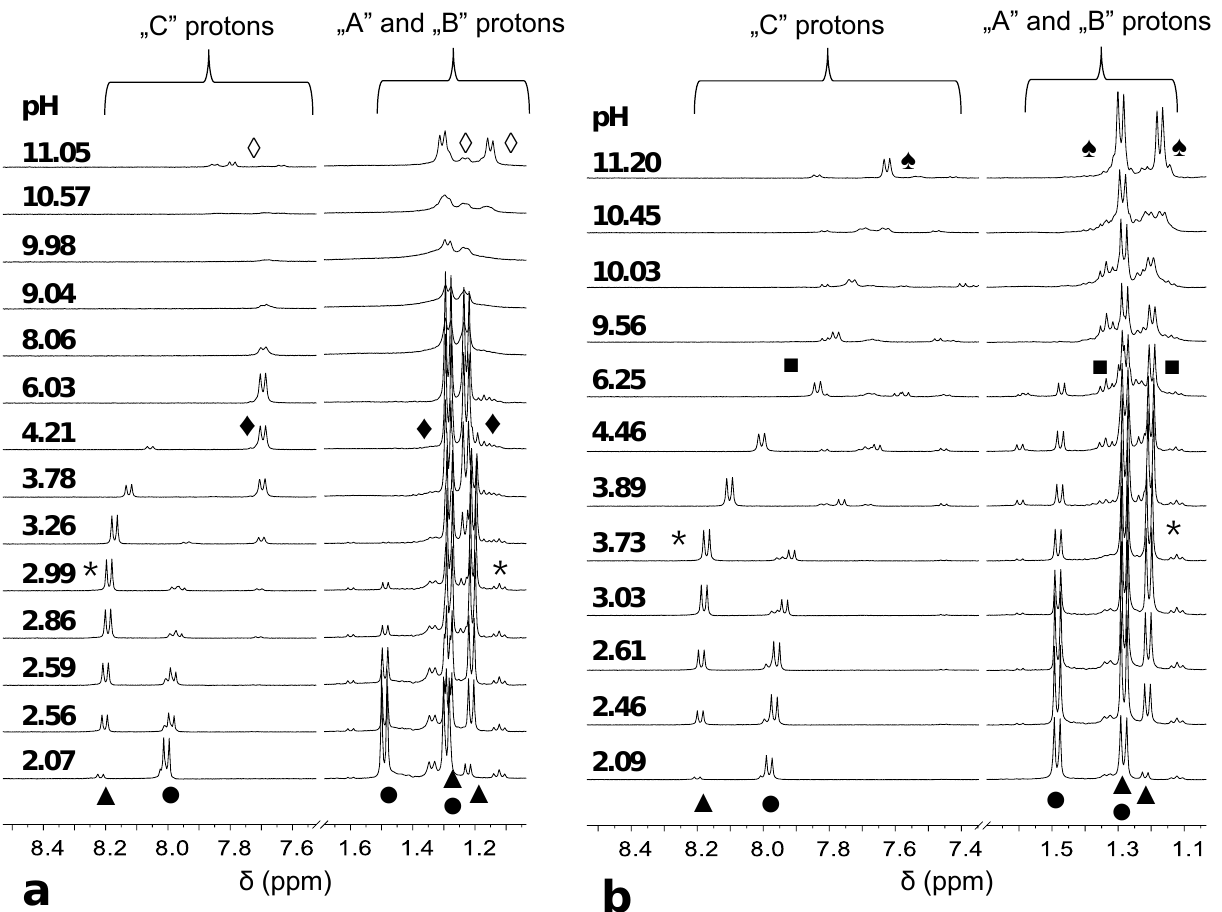
Figure 3. pH-dependence of the NMR signals belonging to the Ala -CH 3 protons (A and B) and pyridinone -CH protons (C) registered at 2:1 ( a ) and 1:1 ( b ) Pd(II) to ligand ratio with L1. For notations, see Scheme 1. Symbols represent the signals belonging to the following species: [H 3 (L1)] 2+ (●), [PdHL] 2+ ( ▲ ), [PdL] + (*), [Pd 2 H – 2 L] + ( ♦ ), [Pd 2 H – 3 L)] and [Pd 2 H – 4 L)] − ( ◊ ), [PdH – 1 L] ( ■ ), [PdH – 3 L] 2− ( ♠ ).